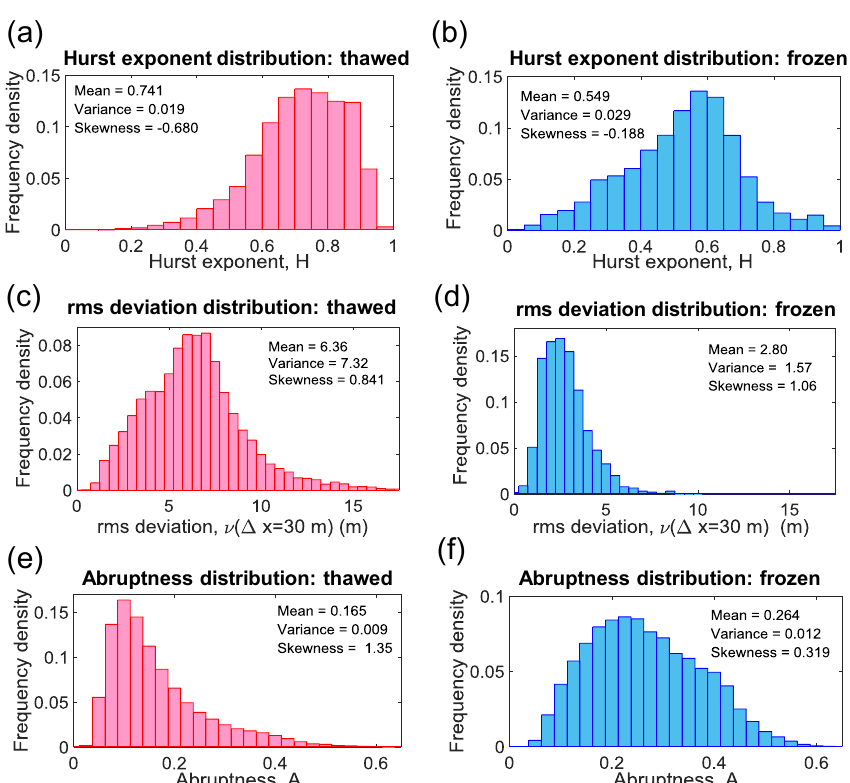
Figure 8. Distributions from basal RES analysis in thawed and frozen regions of the northern GrIS (corresponding to flight-track data in Fig. 6): (a) Hurst exponent, H , in thawed regions; (b) H in frozen regions; (c) rms deviation, ν((cid:49)x = 30m), in thawed regions; (d) ν((cid:49)x = 30m) in frozen regions; (e) abruptness, A , in thawed regions; (f) A in frozen regions. The data subsets correspond to the red (thawed) and blue (frozen) regions of the map in Fig.